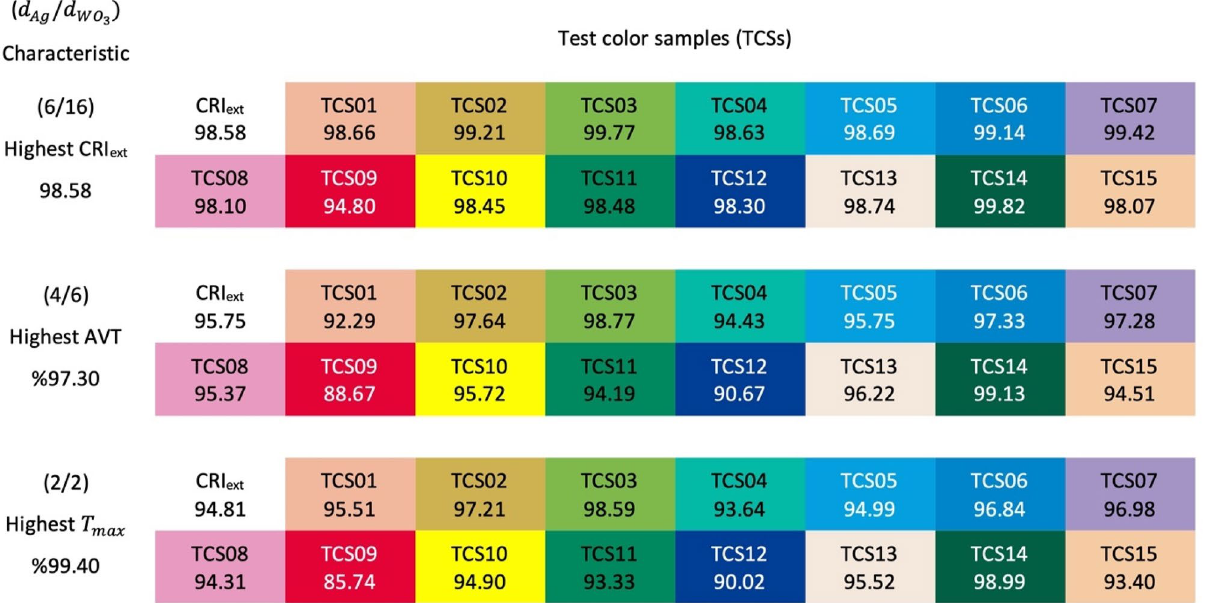
Figure 7. TCS classification of transparent contact structures. CRI for each test colour sample of MoO 3 /Ag/ WO 3 (10/ d Ag / d WO 3 nm) transparent contact structure with the highest AVT ( d Ag = 4 nm, d WO 3 = 6 nm), highest CRI ext ( d Ag = 6 nm, d WO 3 = 16 nm) and highest transmittance ( d Ag = 2 nm, d WO 3 = 2